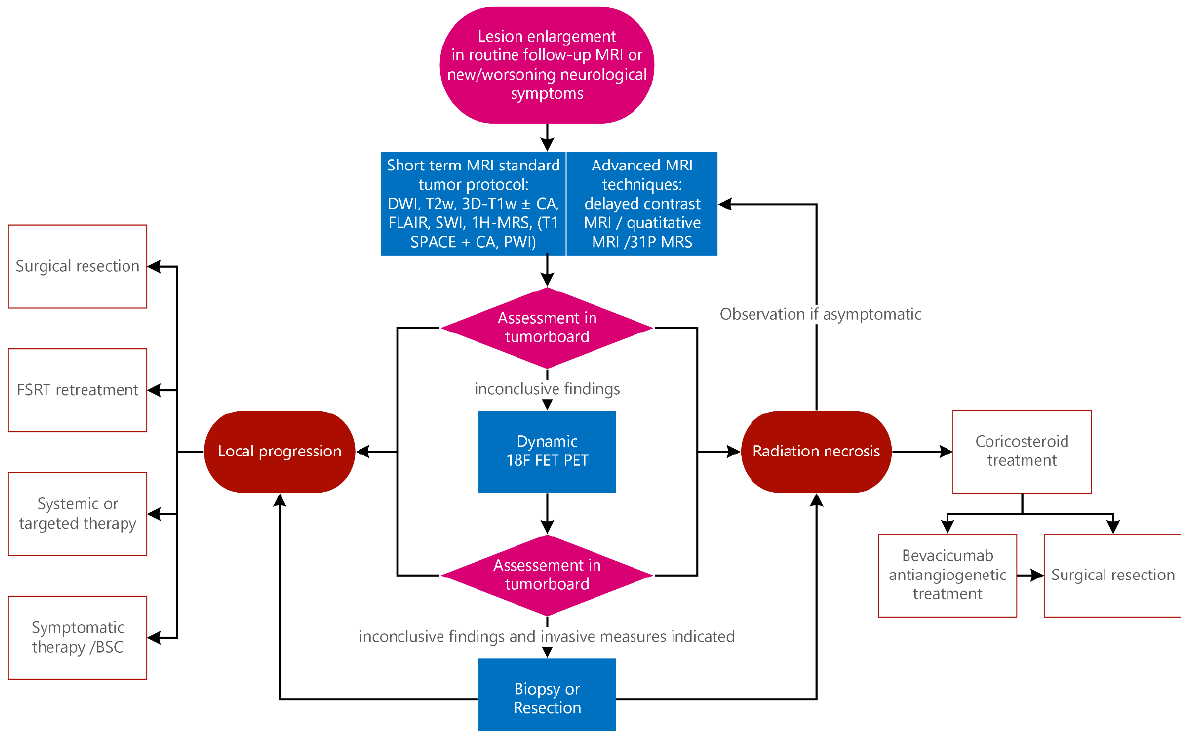
Figure 1. Diagnostic and therapeutic algorithm for suspected tumor recurrence or radiation necrosis. In cases of tumor enlargement on MRI or neurologic symptoms suggestive of tumor progression, a short-term MRI scan is performed using advanced new techniques. If the results are inconclusive, a dynamic 18 F-FET PET scan or, in selected cases, a biopsy or surgical resection may be performed. All results are discussed in an interdisciplinary tumor board (with specialists in neurology, neuro-